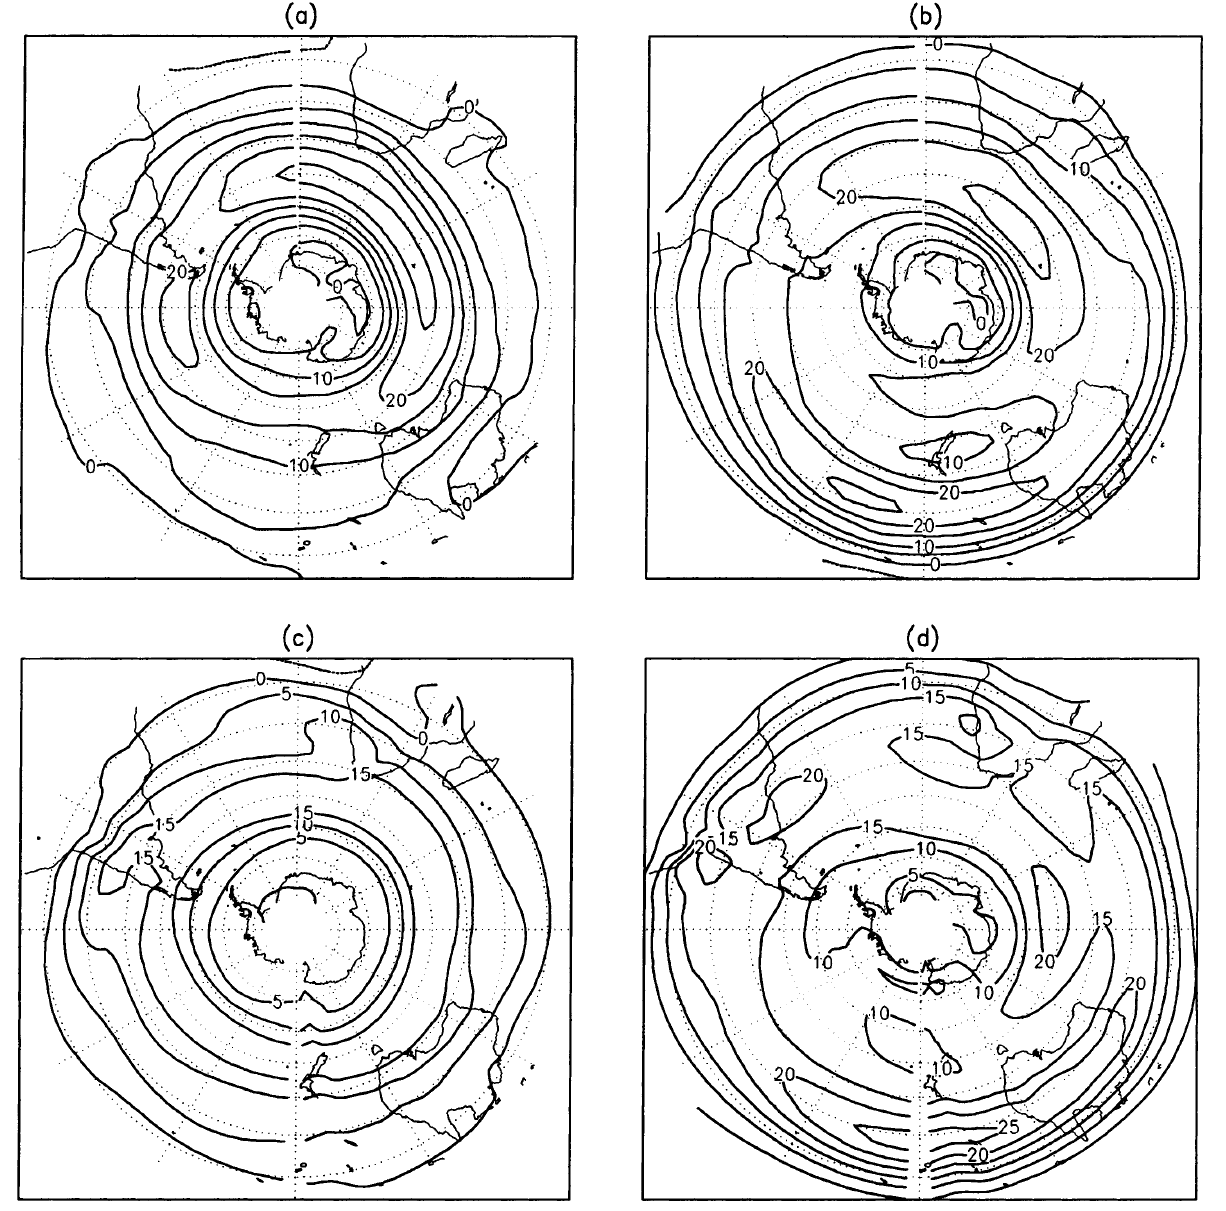
Fig. 3a–d. Mean zonal wind at 500 hPa from observations ( upper panels ) and the model ( lower panels ), for summer ( a, c ) and winter ( b, d ). Contour interval is 5 ms )